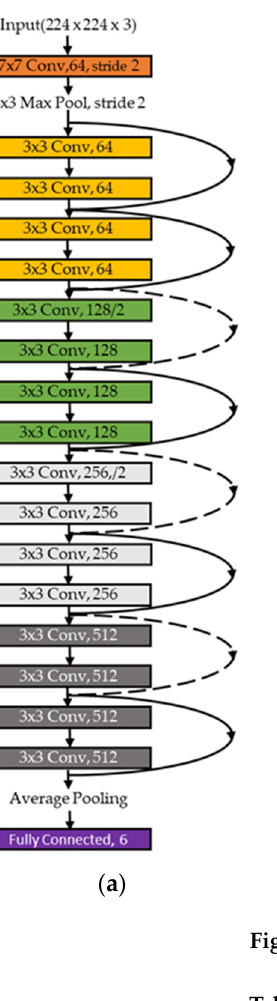
Table 2, in the ResNet-18 architecture, the two-layer blocks are replaced with three-layer blocks to form the 50-layer network.